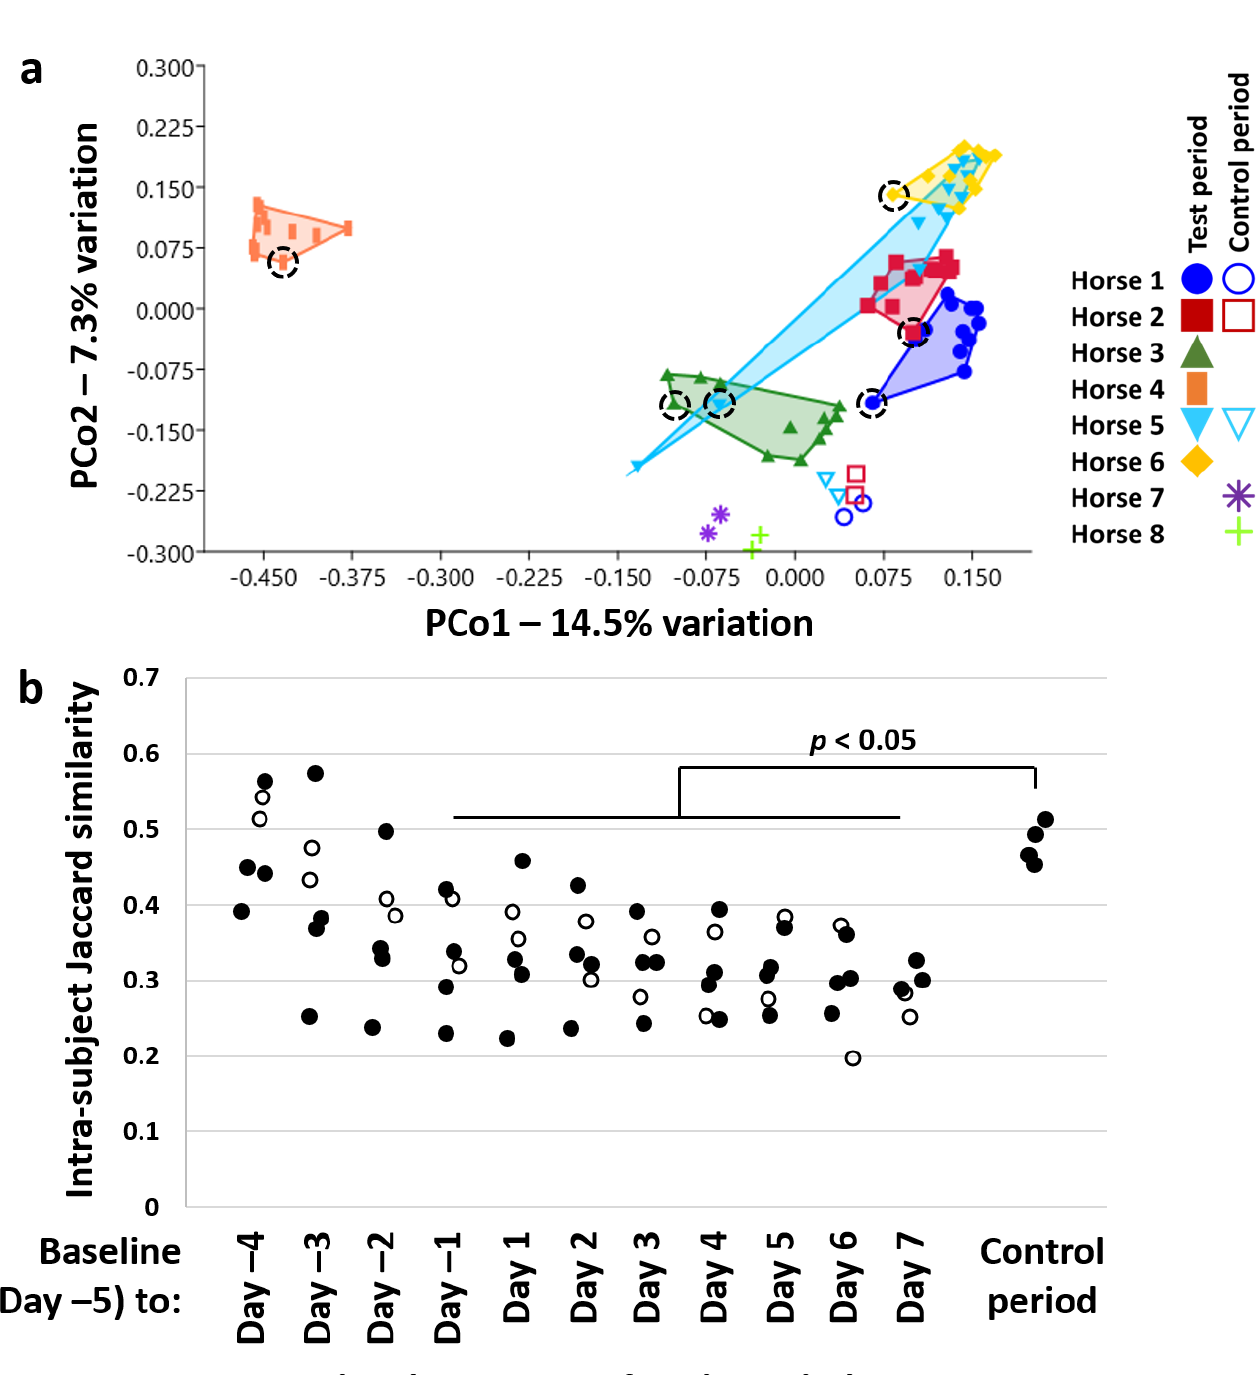
Figure 2. Consistent change in β -diversity rapidly following diet change. Principal coordinate analysis (PCoA) plot ordinated using Jaccard similarities, showing the relationship in β -diversity among fecal samples collected daily from the six horses (color-coded, legend at right) in the study, and paired samples from five control horses remaining on pasture, collected one week apart. Samples denoted by like symbols came from the same horse. Dotted circles indicate the initial sample from each horse upon movement off pasture ( a ); dot plot showing intra-subject Jaccard similarity between baseline (Day − 5) and each successive day off pasture in the horses switched to an all-hay diet ( n = 6) and receiving metformin ( n = 4, closed circles), and between horses at Day 1 and Day 7 of the Control period ( n = 5). Bracket indicates p < 0.05 versus control, ANOVA with Dunn’s post hoc ( b ).